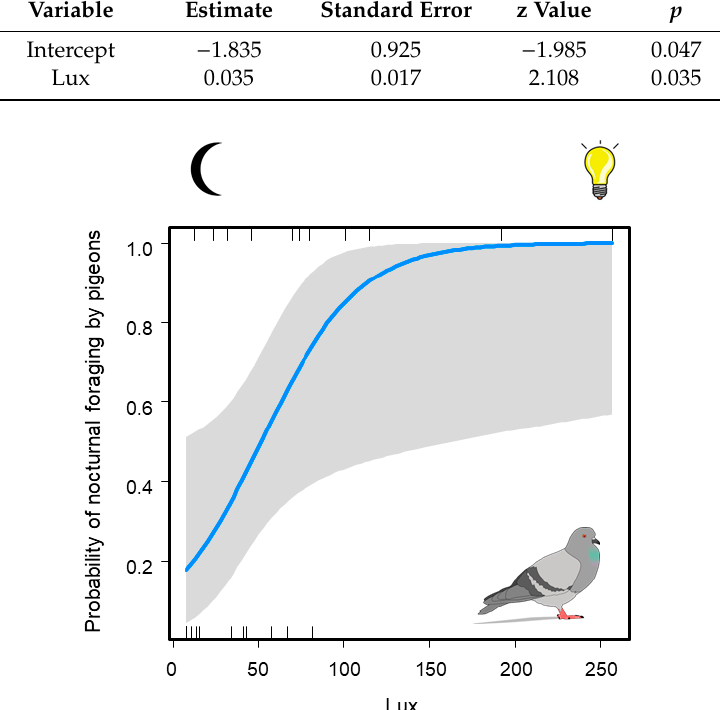
Figure 1. Probability of nocturnal foraging by the Feral Pigeon ( Columba livia f. domestica ) in Salta and Buenos Aires in relation to light intensity (mean lux). The vertical lines indicate the mean lux values of presence sites (above) and absence sites (below). The blue line represents the fitted curve the grey area represents the confidence intervals at 95%.